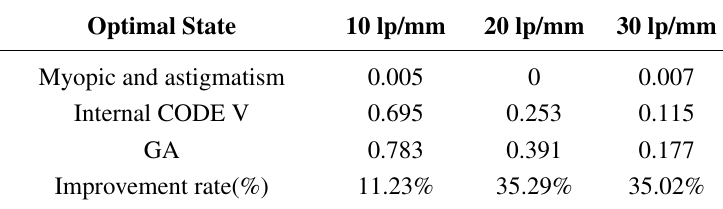
Table 15. MTF values for pupil size 6